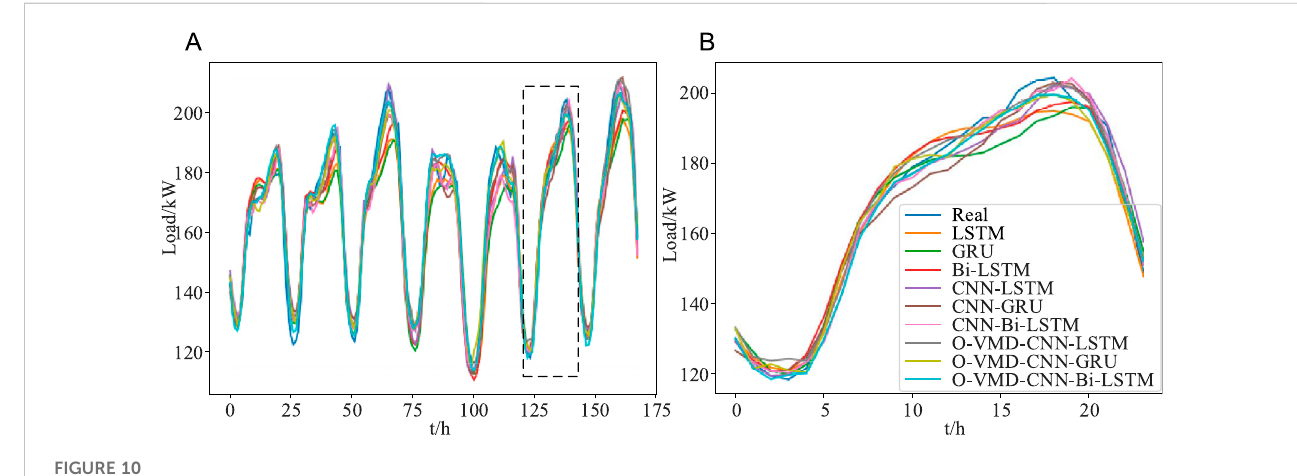
FIGURE 10 (A) Load forecasting results for a continuous week. (B) Load forecasting results of 1